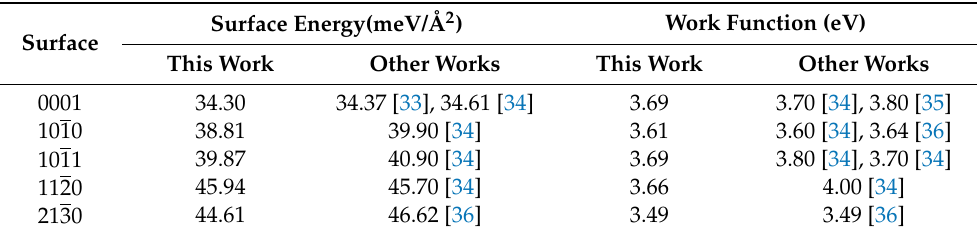
Table 1. Surface energy and work function of different surfaces of Mg.